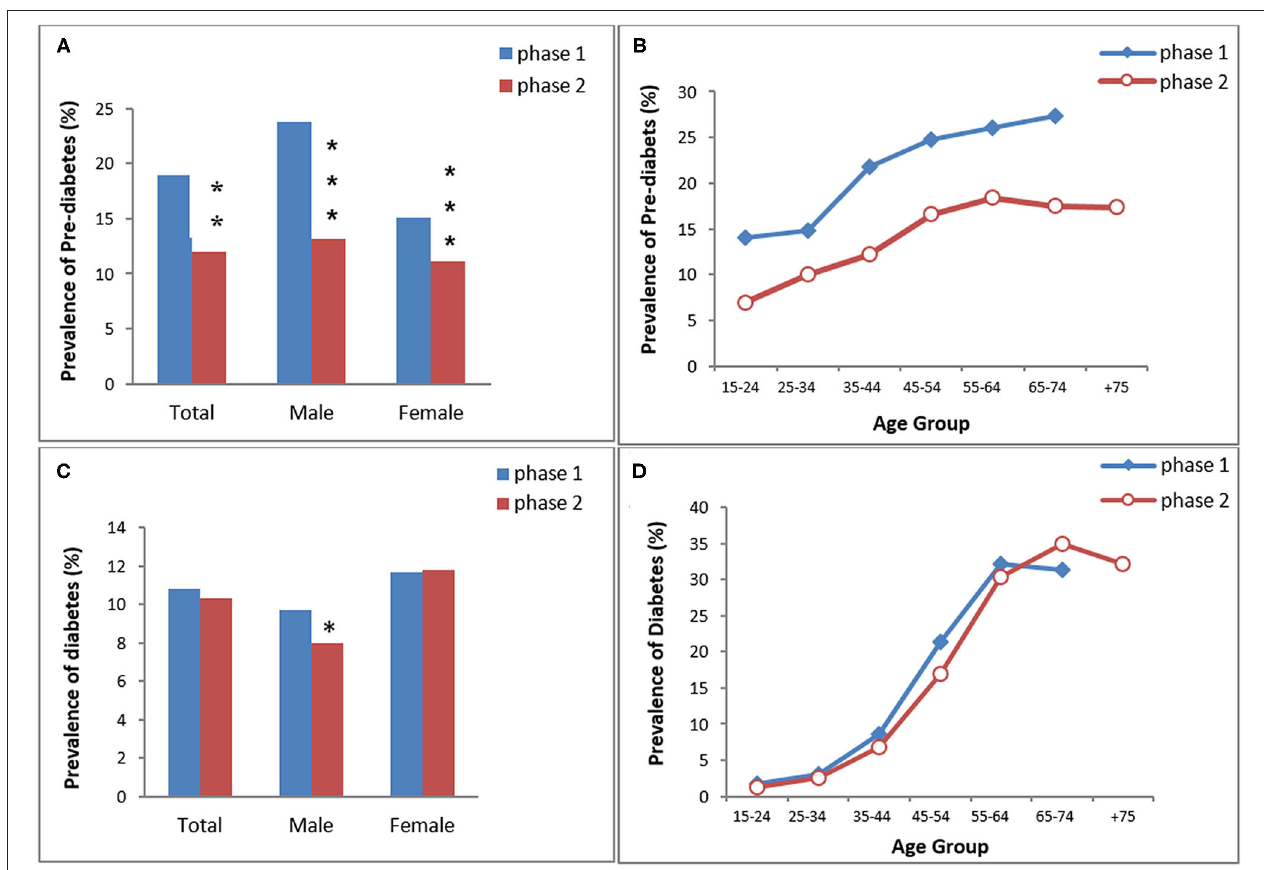
FIGURE 2 | The prevalence of pre-diabetes (A,B) and diabetes (C,D) in KERCADRS by sex and age groups. Total participants = 9,959 in phase 2 and 5,900 in phase 1. The data of phase 1 were used here for comparison and are extracted from our paper published previously ( 20). * P < 0.05, ** P < 0.01, *** P < 0.001 compared to phase